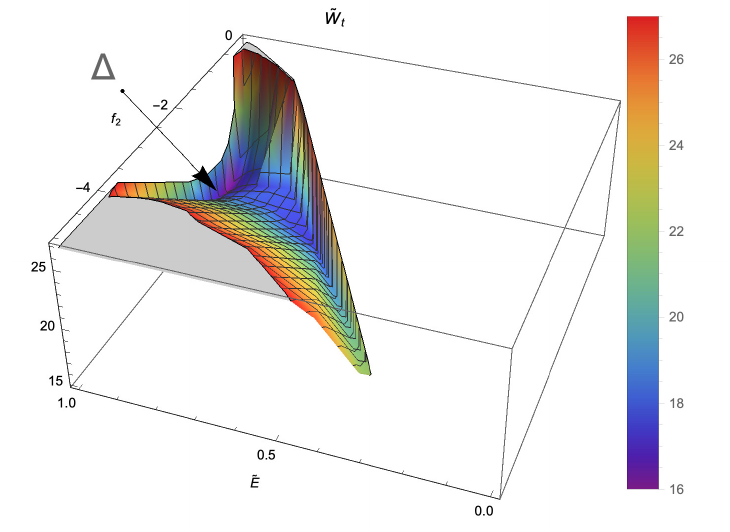
Figure 3. Contour plot of the total energy ˜ W t ( ˜ E , f 2 ) from Equation (47). ∆ shows the location of the (cid:8) (cid:9) f 2 , ˜ E mass gap in the plane.